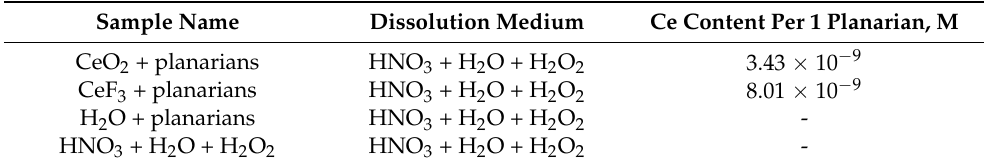
Table 1. The content of cerium species in planarians as determined using the method of mass spectrometry with inductively coupled